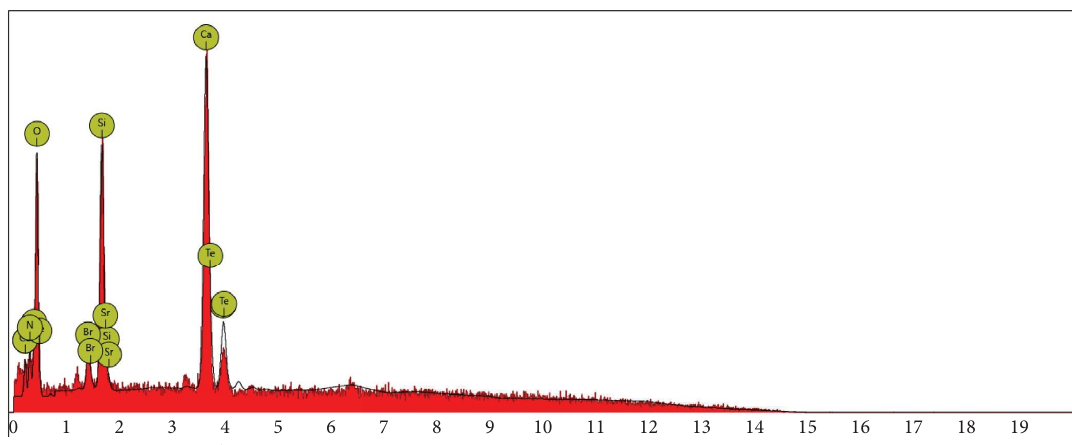
Figure 26: Graphical representation of elements concentration for M1 sample room temperature.